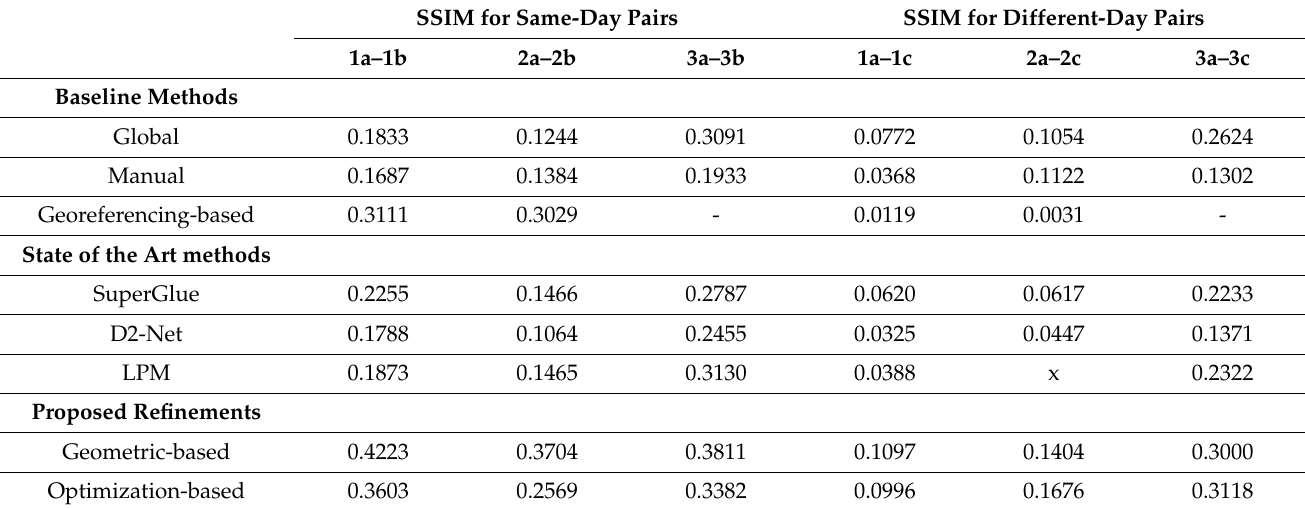
Table 6. SSIM results between transformed and reference images for the proposed global, geometric-based, and optimization- based approaches with the baseline and state-of-the-art image registration methods. Note that there are no geo-coordinates provided for the images 3a, 3b, and